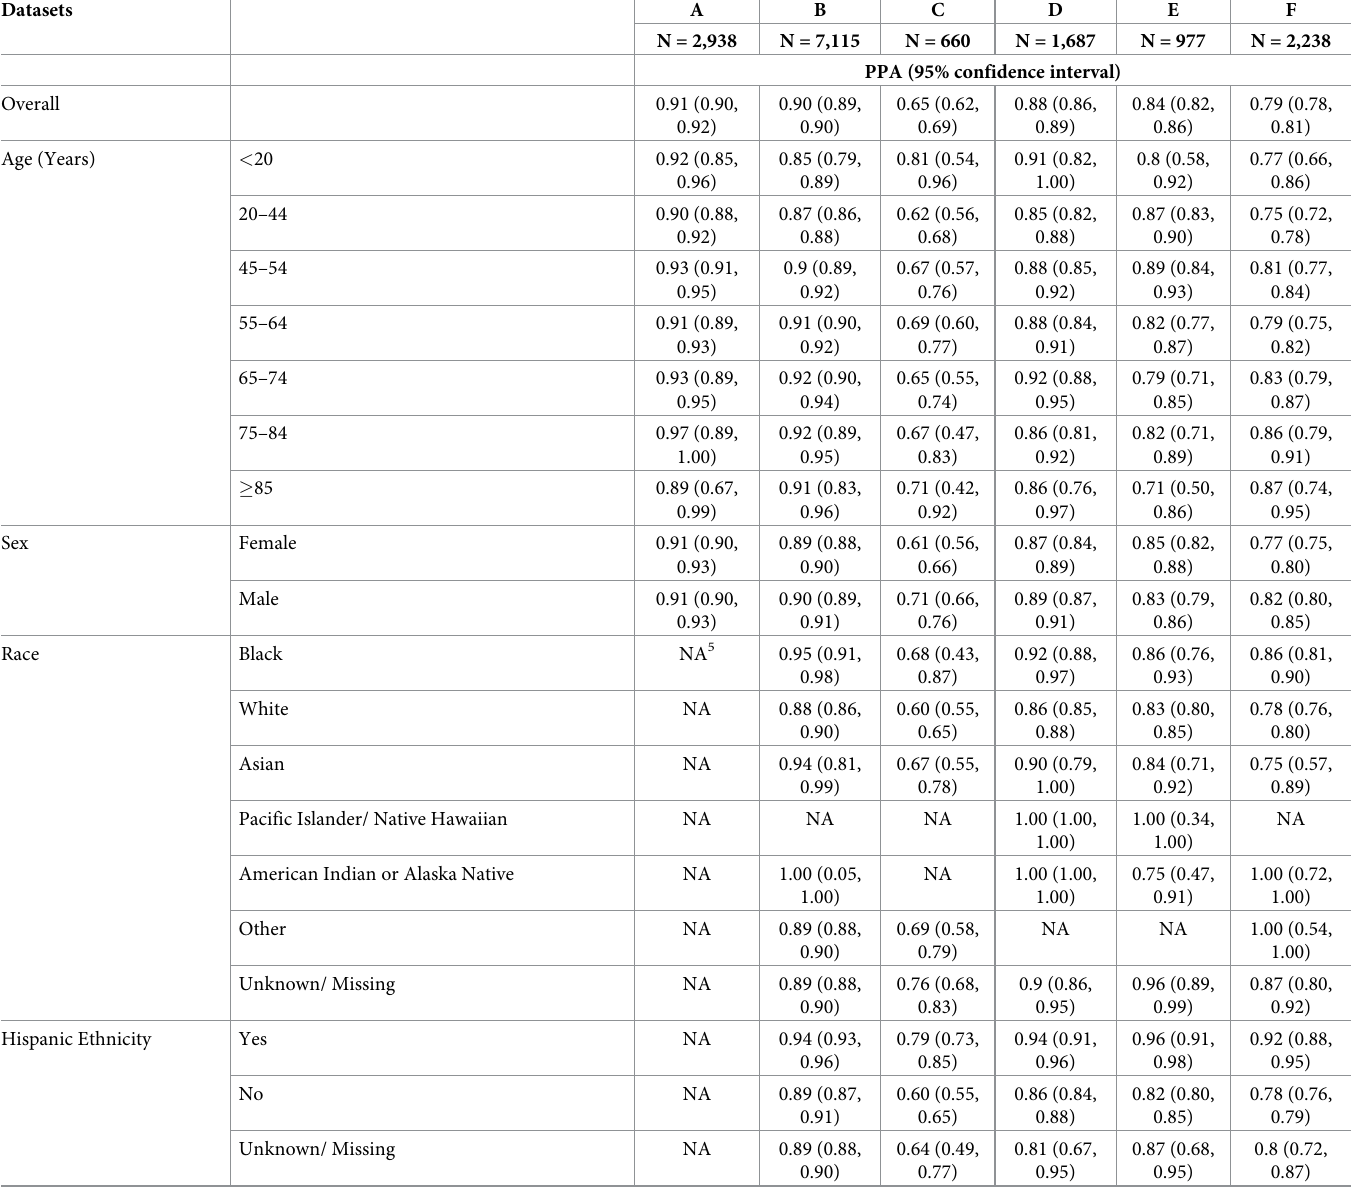
Table 2. Positive percent agreement (PPA) 14–90 days after positive RNA test.